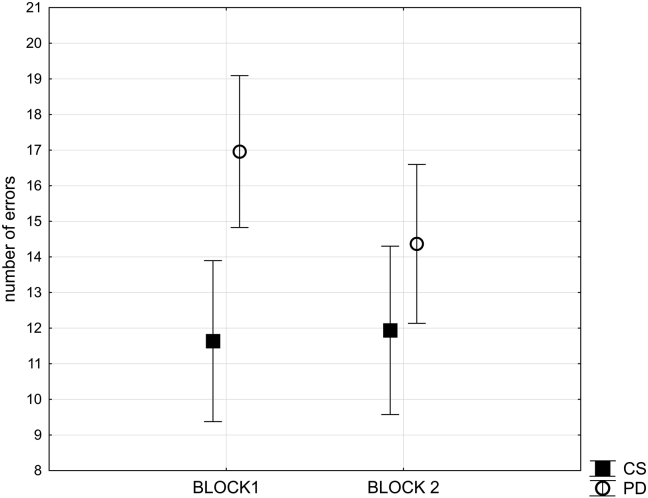
Effect of PD pathology on error rate. This figure illustrates mean number of error rates compared across the patients with PD and the matched control group (CS) for block one and block two the experimental task. Bars represent standard error of the mean.